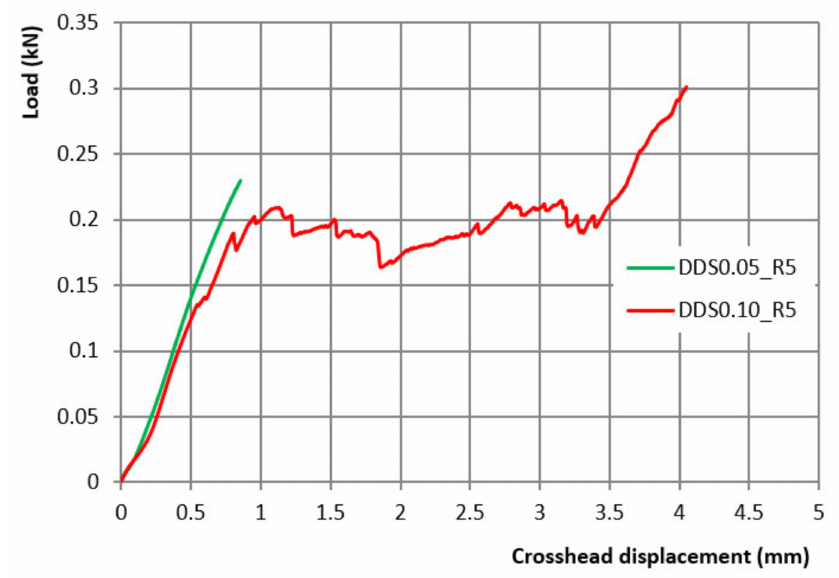
Figure 7. Load-crosshead curve of DDS0.05_R5 (green line) and DDS 0.10_R5 (red line).